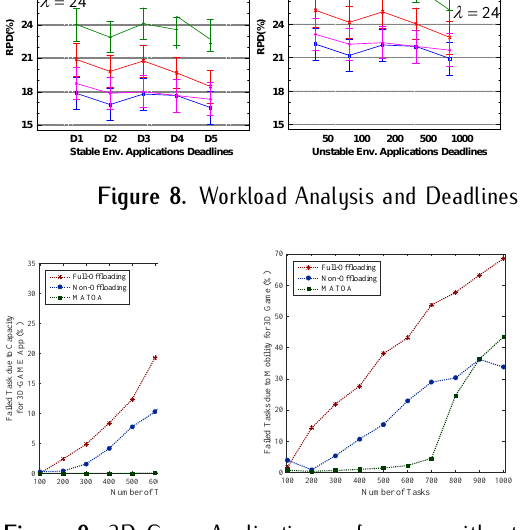
Figure 9. 3D-Game Application performance without and with mobility